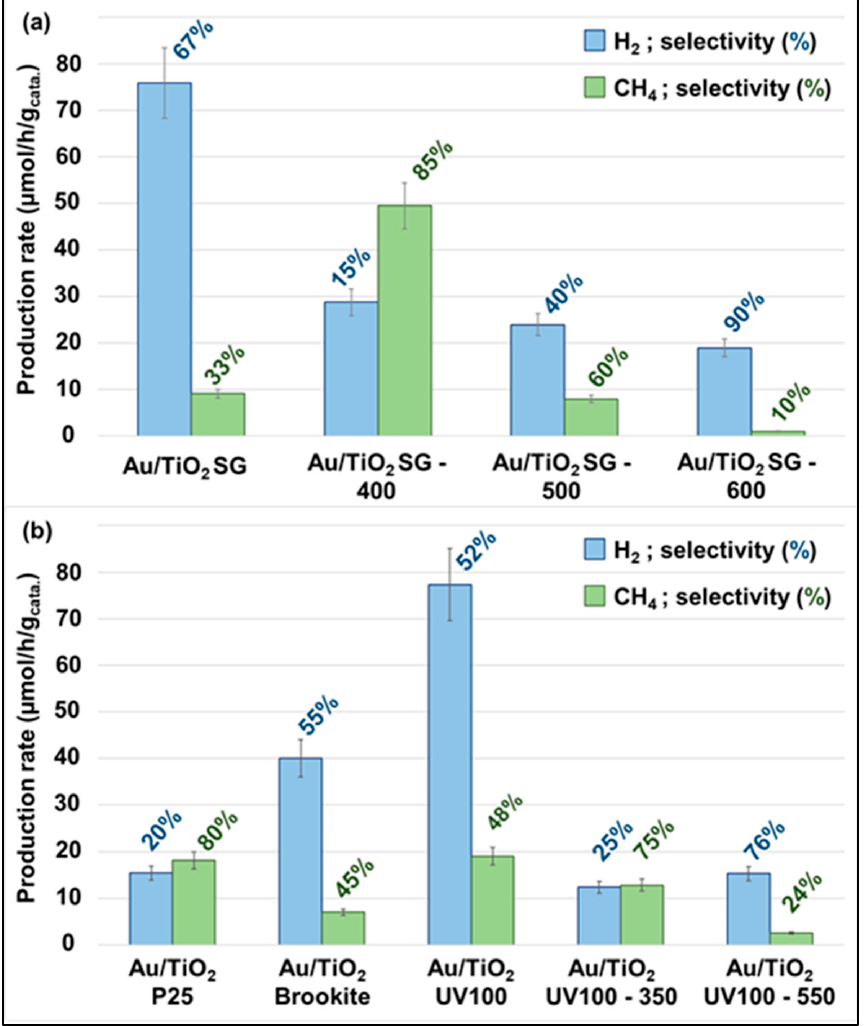
Figure 5. Specific H 2 and CH 4 production rate and electronic selectivity (CO 2 /H 2 O = 96/4 mol. ratio), after 5 h at 0.3 mL/min continuous flow under solar light irradiation of ( a ) Au/TiO 2 SG-X and ( b ) Au/TiO 2 P25, Au/TiO 2 brookite and Au/TiO 2 UV100-X commercial-based samples. As all those photocatalysts exhibit large differences in surface area, normalized reaction rates were calculated (Figure 6), allowing comparison of the intrinsic activ- ities. Considering the normalized CH 4 production rates, the following order of ac- tivity was observed: Au/TiO 2 P25 > Au/TiO 2 SG-400 > Au/TiO 2 SG-500 > Au/TiO 2 UV100-350 >Au/TiO 2 UV100> Au/TiO 2 brookite > Au/TiO 2 SG ≈ Au/TiO 2 SG-500 > Au/TiO 2 SG-600, suggesting that the surface area parameter is an impacting parameter but not the only